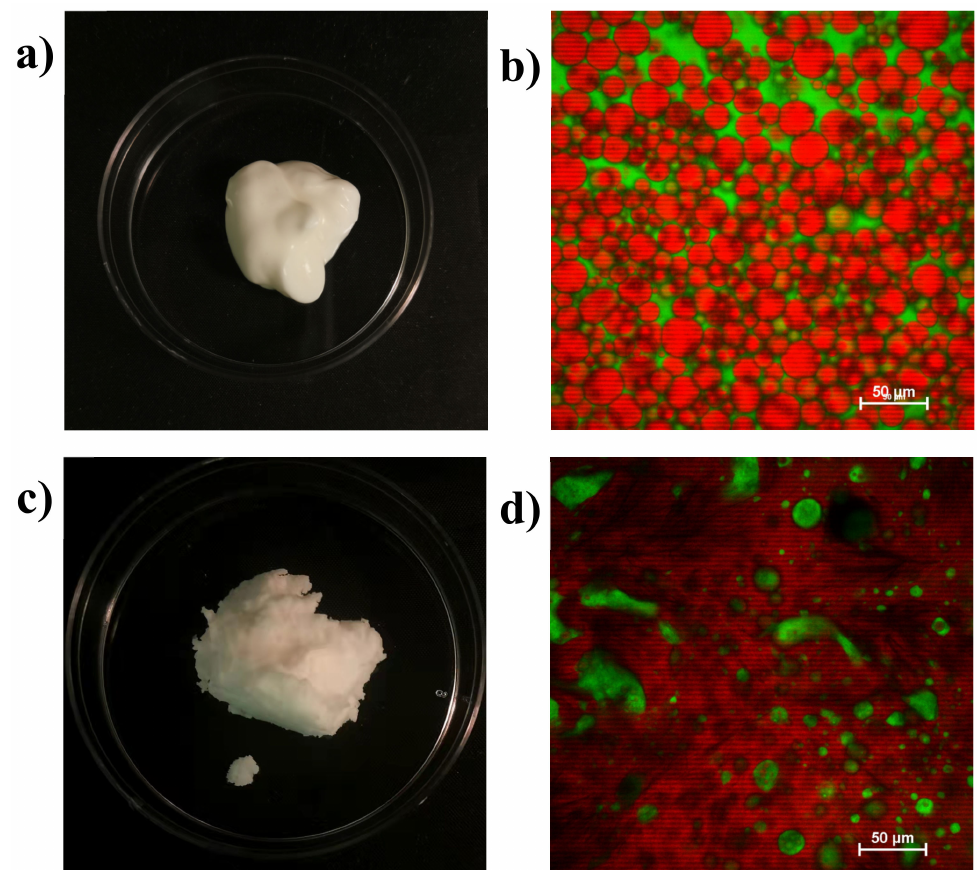
Figure 6. Appearance ( a ) and microstructure ( b ) of HIPEs containing soybean oil and appearance ( c ) and microstructure ( d ) of coconut oil characterized by digital photography and confocal fluores- cence microscopy. The oil is stained red and the proteins green in the microscopy